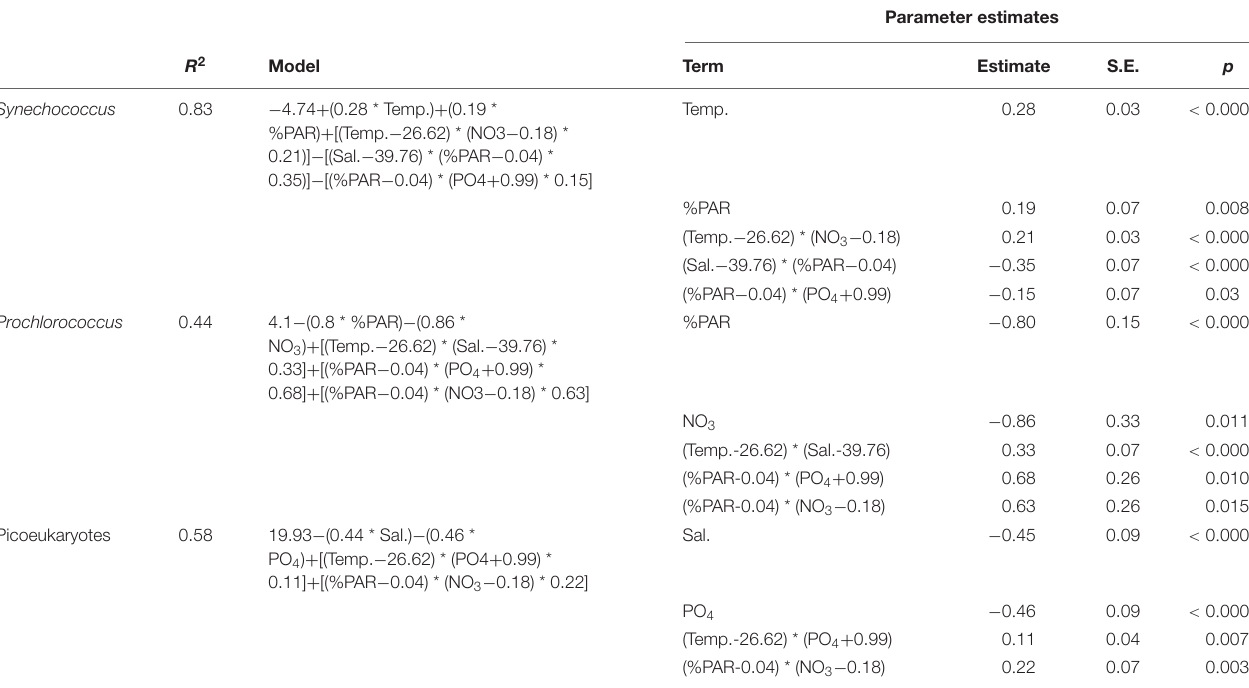
TABLE 4 | Best model for each picophytoplankton group (as determined by general stepwise regression), with forward selection by AICc and the corresponding parameter estimates for each term in the